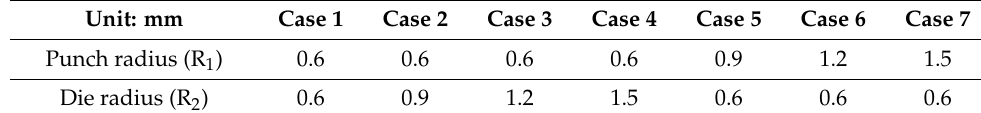
Table 1. Design variables in the preforming process.